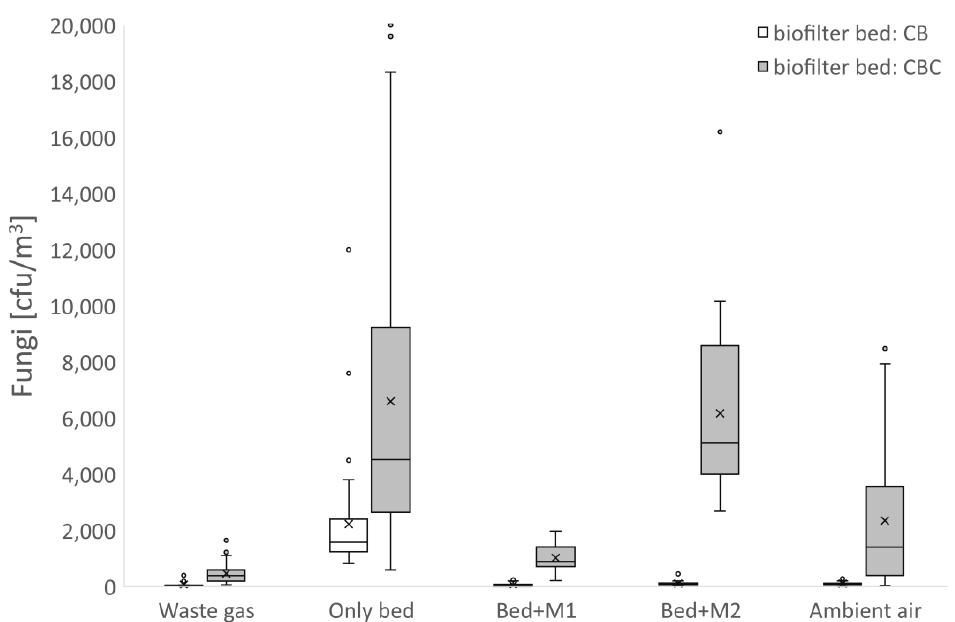
Figure 4. Total number of fungi [cfu/m 3 ] in the waste gas, gases treated by a conventional biofilter (only bed) and combined biofilter (bed + membrane M1 or M2), and the ambient air. For a detailed legend, see Figure 3.